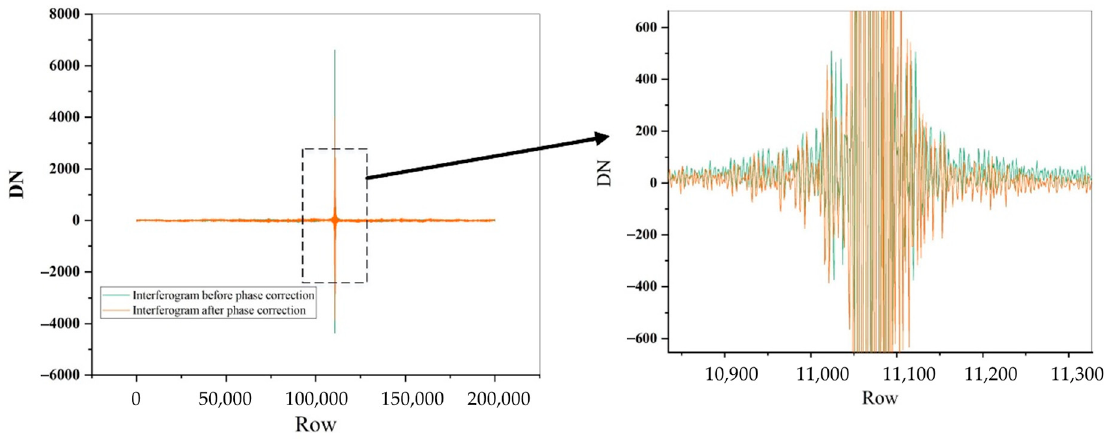
Figure 14. Comparison of interferograms before and after phase